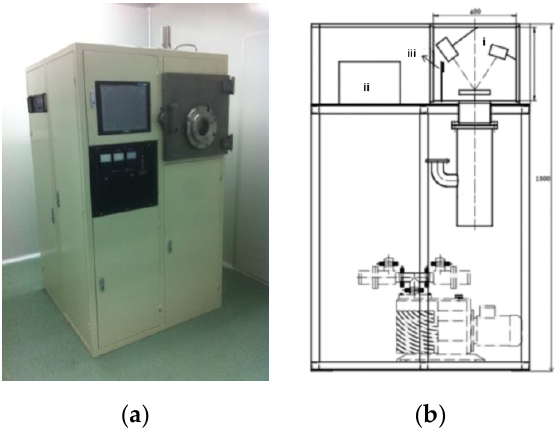
Figure 2. ( a ) Photo of the EBVD equipment; ( b ) schematic representation of the EBVD technology: (i) electron beam deposition system in vacuum chamber; (ii) control system; (iii) coating thickness control system.